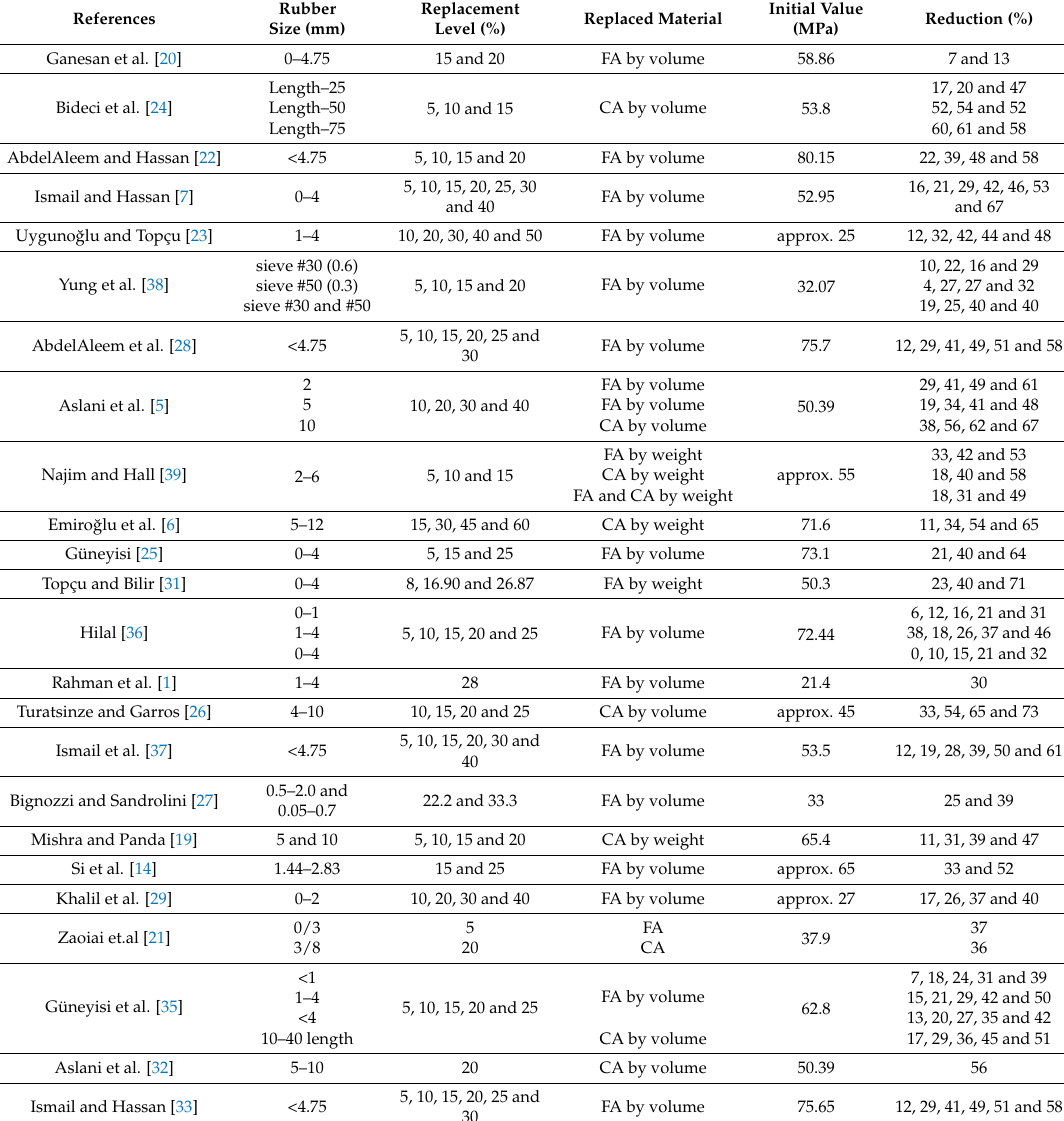
Table 3. Influence of rubber size, replacement level and replaced material on 28-days compressive strength of self-compacting concrete